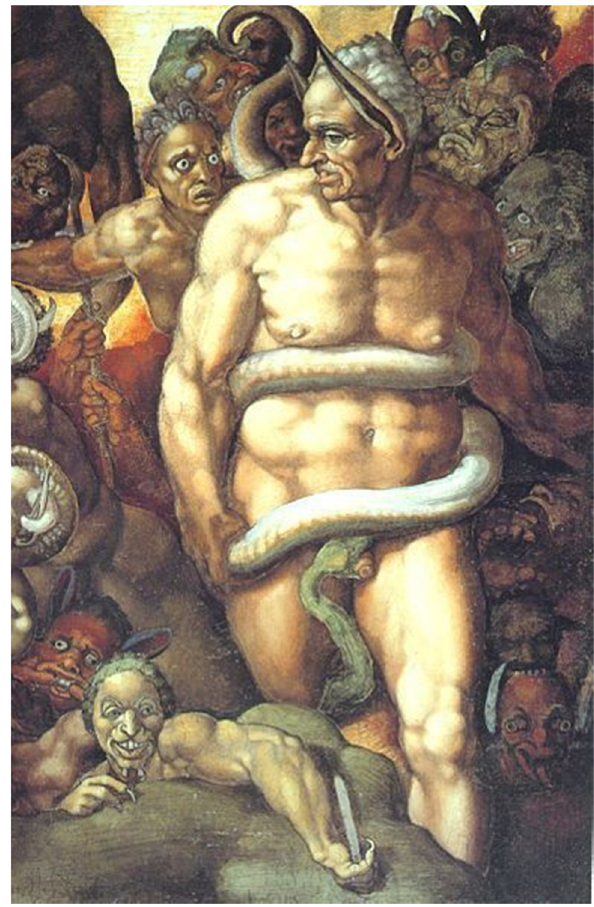
Figure 2: Michelangelo, Minos detail from the Last Judgment , 1536 – 1541. Sistine Chapel, Rome. Public